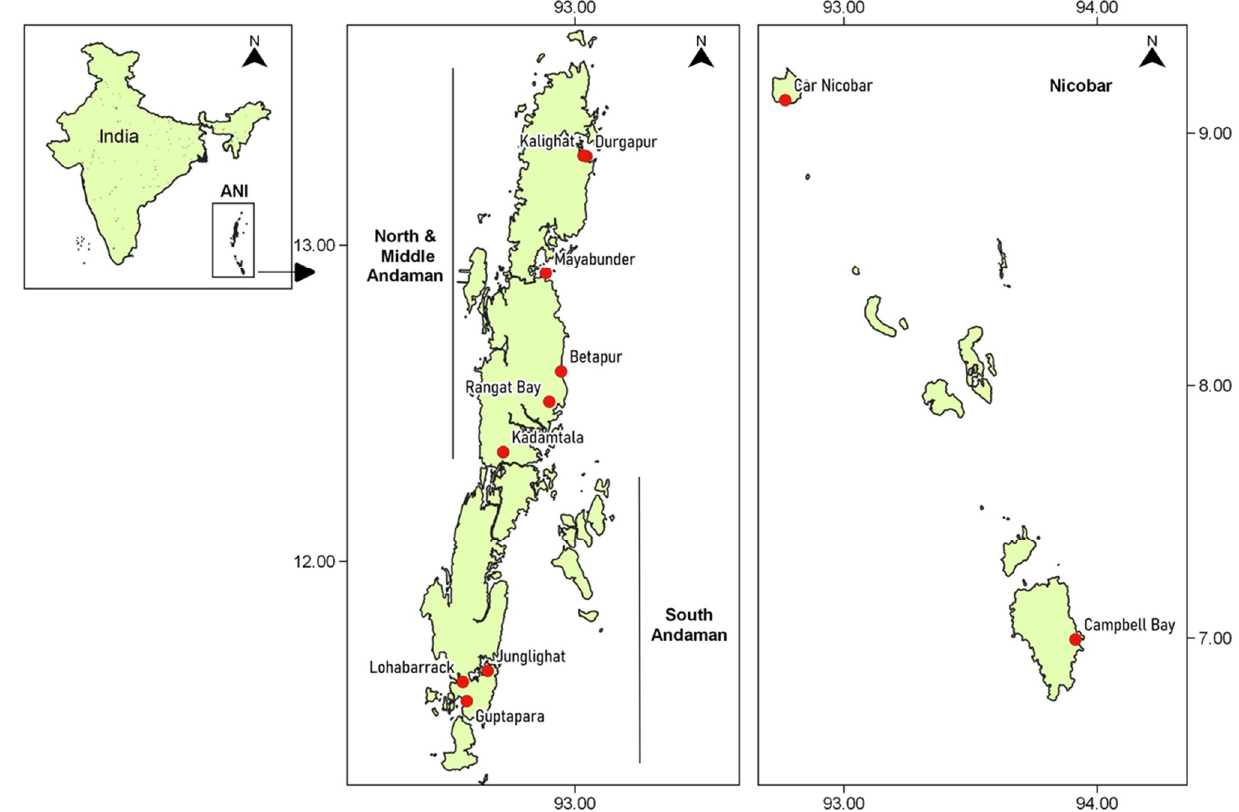
Figure 1. Map showing the sample collection sites in Andaman and Nicobar Archipelago (ANI), India. The wild shrimp and crab samples were collected from various fish landing centres located in all the three districts of ANI namely, North and Middle Andaman, South Andaman and Nicobar districts.